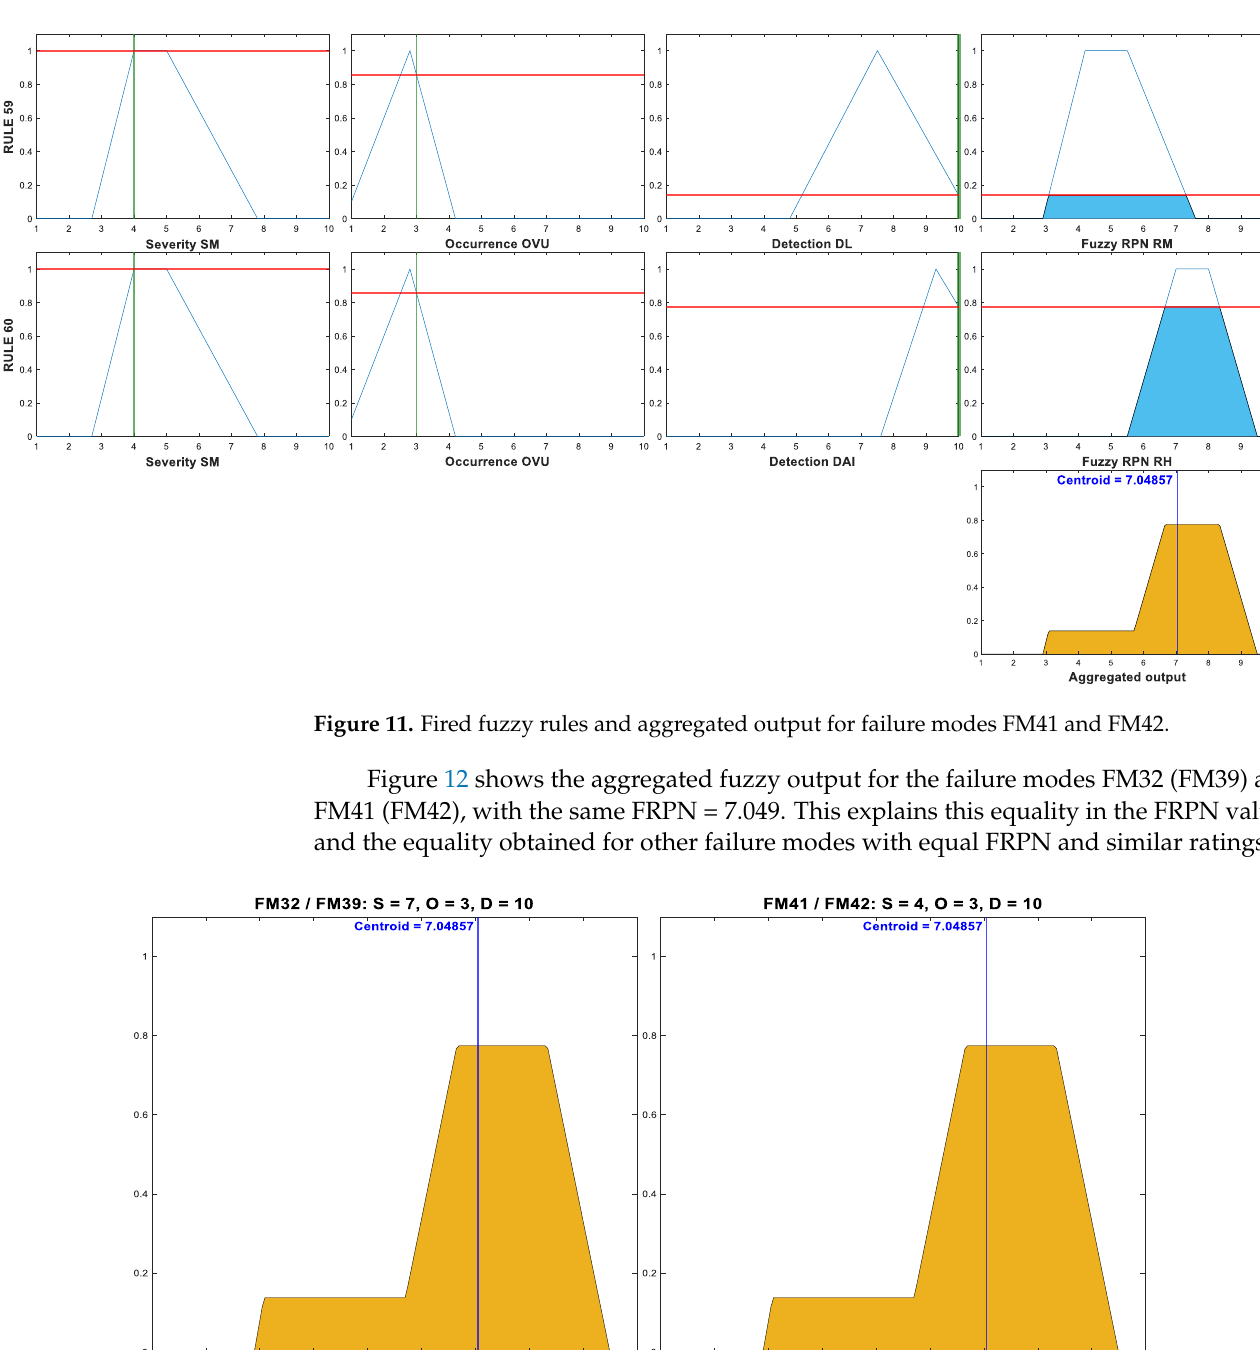
Figure 12. Fuzzy output for the failure modes FM32 (FM39) and FM41 (FM42) with the same FRPN = 7.049.